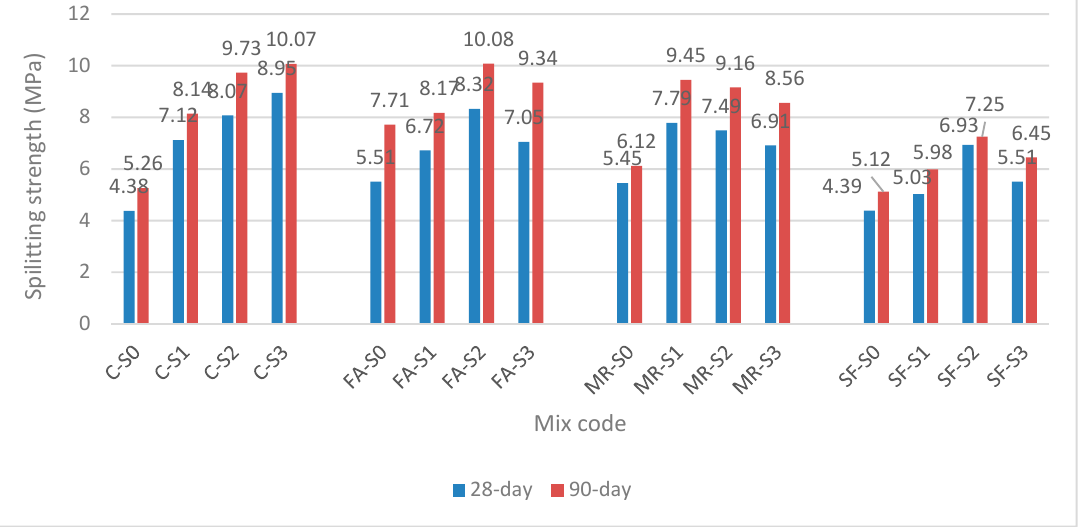
Figure 6. Splitting strength test at 28 and 90 days.